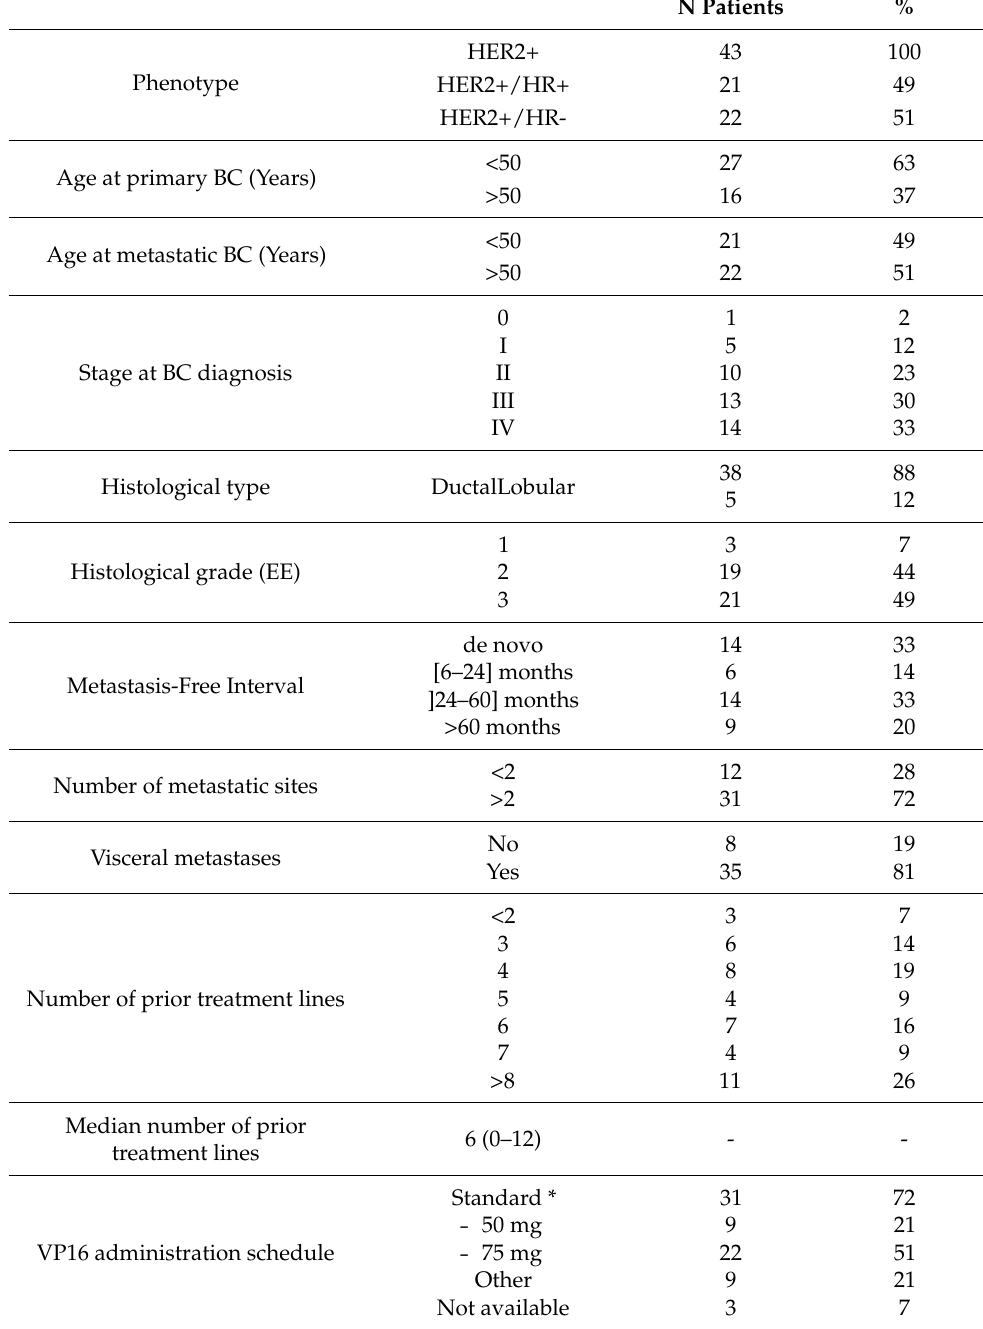
Table 1. Patients’